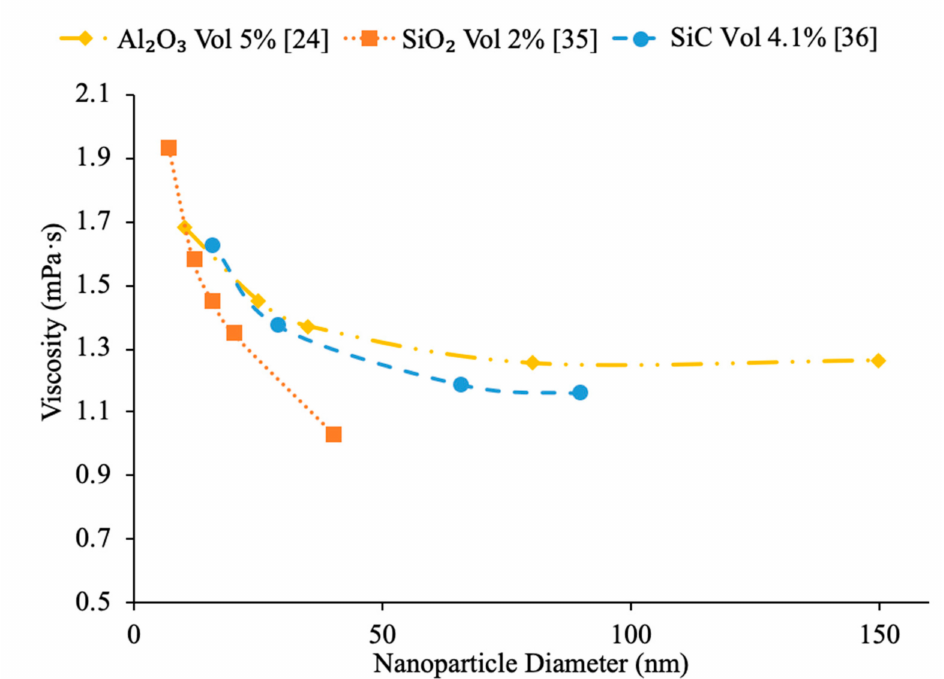
Figure 9. Viscosity of SiO 2 , Al 2 O 3 , and TiO 2 water-based nanofluids as a function of nanoparticle diameter [24,35,36].